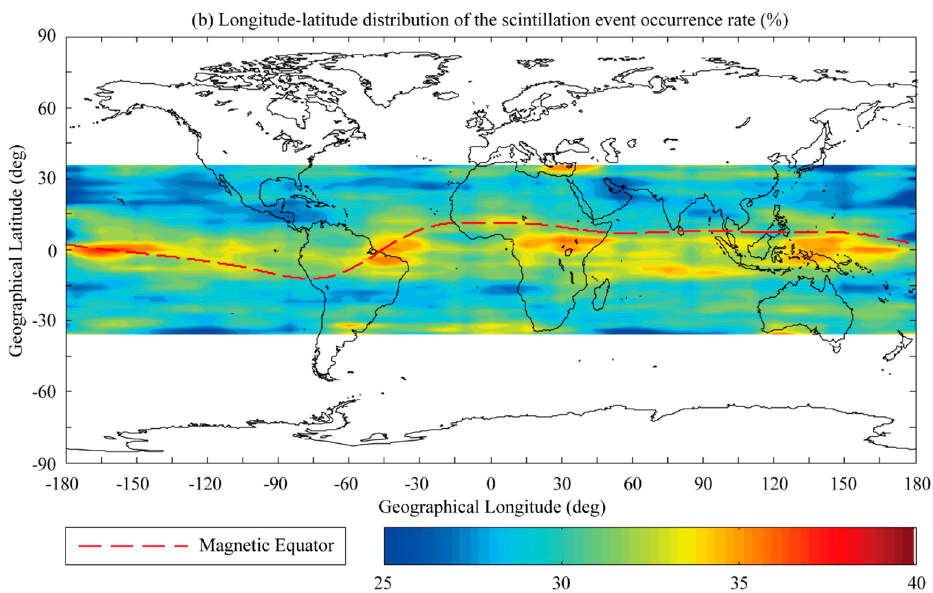
Figure 2. Distribution of the global scintillation events for nighttime (i.e., 18-06 LT) in the 2° × 5° spatial resolution longitude-latitude frame from the CYGNSS satellites in 2017. ( a ) S4 data number in the longitude-latitude frame. ( b ) Longitude-latitude distribution of the scintillation event occurrence rate (%).